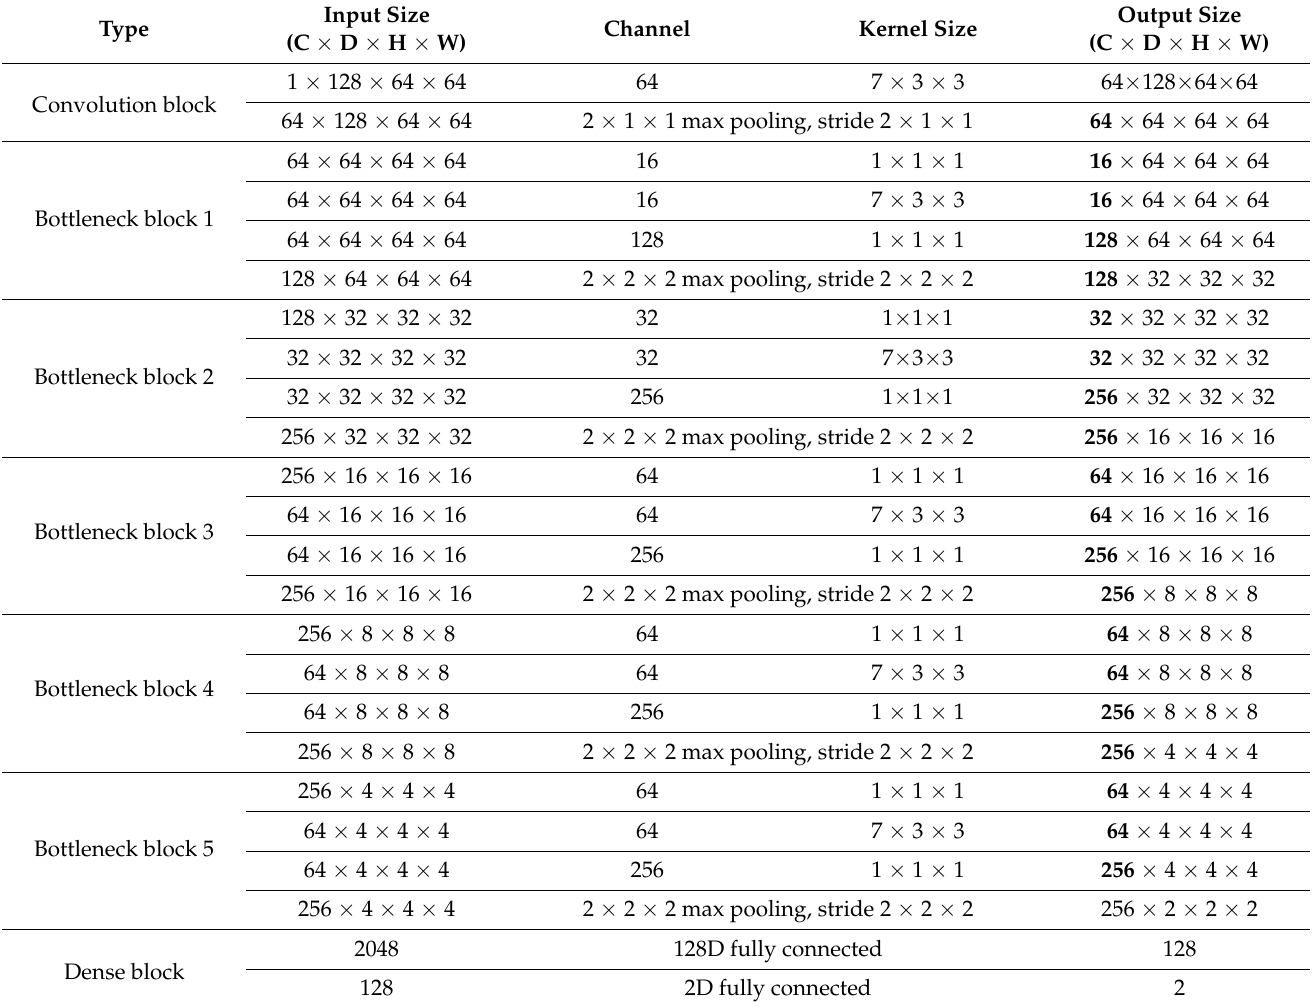
Table 1. Architectural details of the proposed CNN-BN model for EEG-based emotion recognition. Each row denotes a sequence of building blocks. The proposed CNN-BN model consists of a convolution block, five consecutive bottleneck blocks, and a dense block. The bottleneck building block is repeated five times, denoted as bottleneck block 1 to bottleneck block 5. Each convolutional layer is followed by a batch normalization layer, and the kernel size for convolutions is set to 7 × 3 × 3 or 1 × 1 × 1. The stride of all convolution blocks is set to 1. C, D, H, and W represent the number of channels, length, height, and width of the feature map, respectively. The effects of bottleneck blocks on the number of channels in the output data are highlighted in